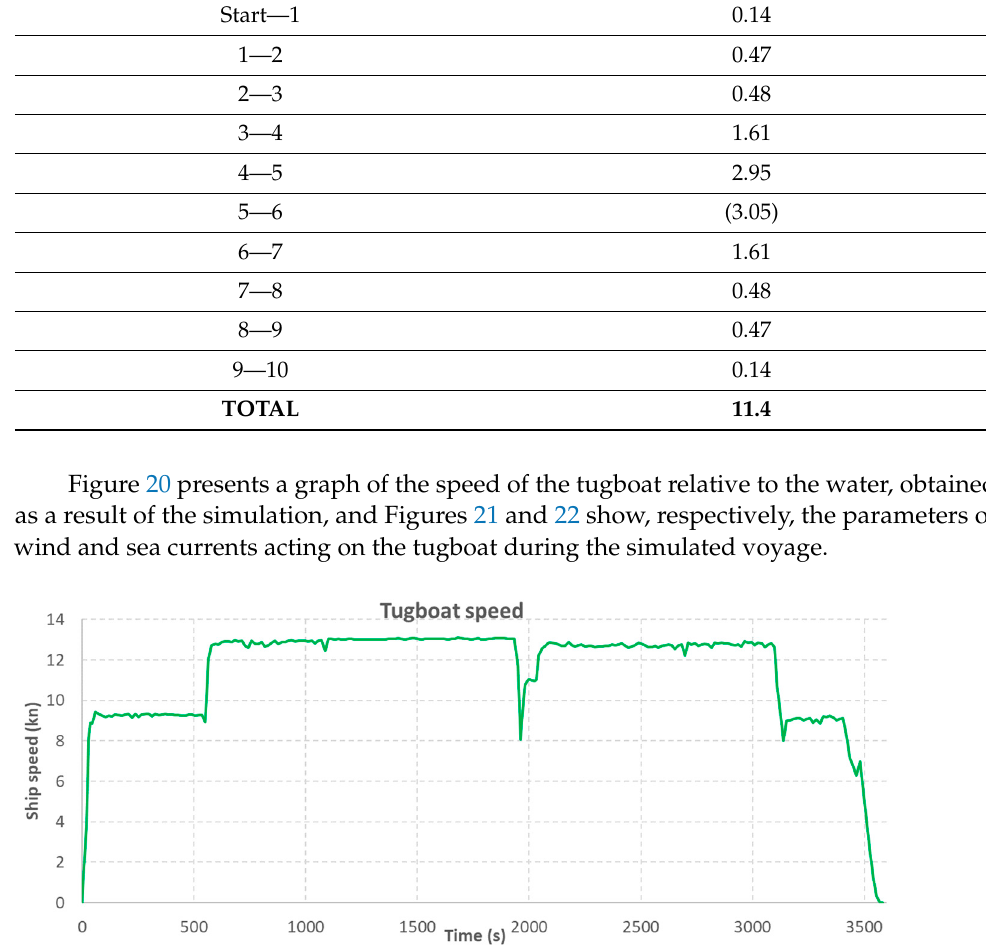
Table 4. Distances between successive turning points of the simulated route.